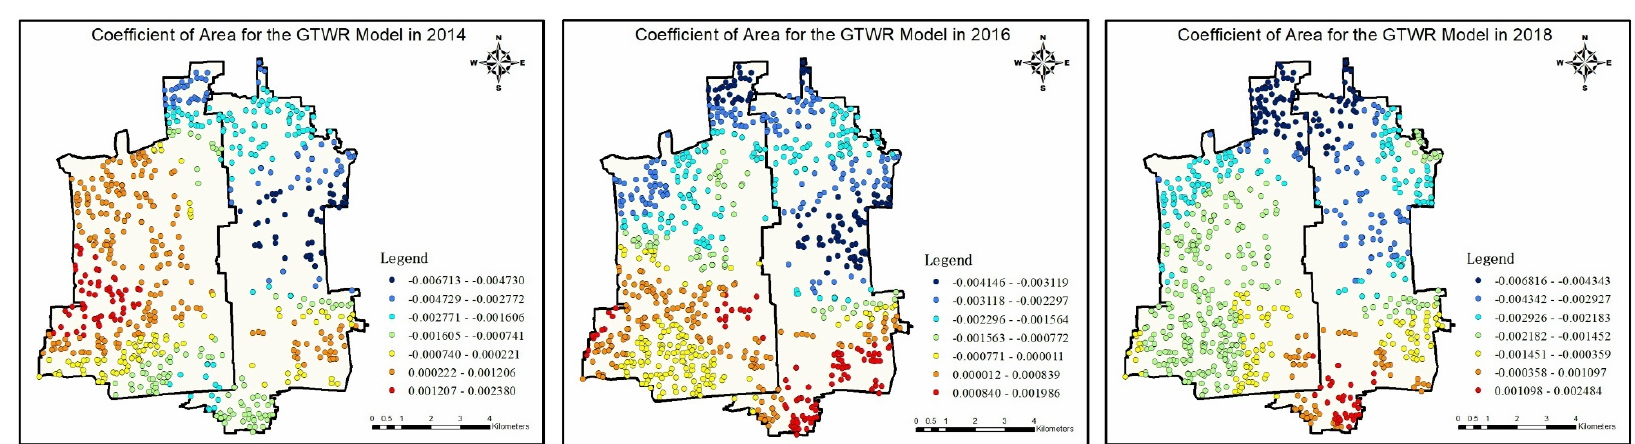
Figure 4. Standard residuals for the GTWR model in 2014, 2016, and 2018.